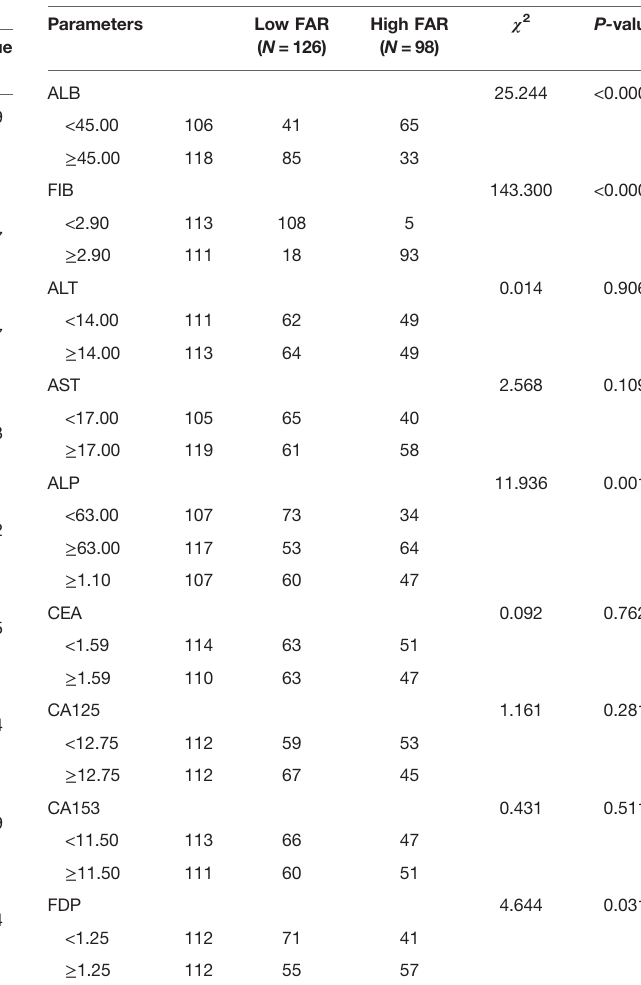
TABLE 3 | Associations between FAR and in fl ammation indices. TABLE 2 | The correlations between FAR and pathological data in triple-